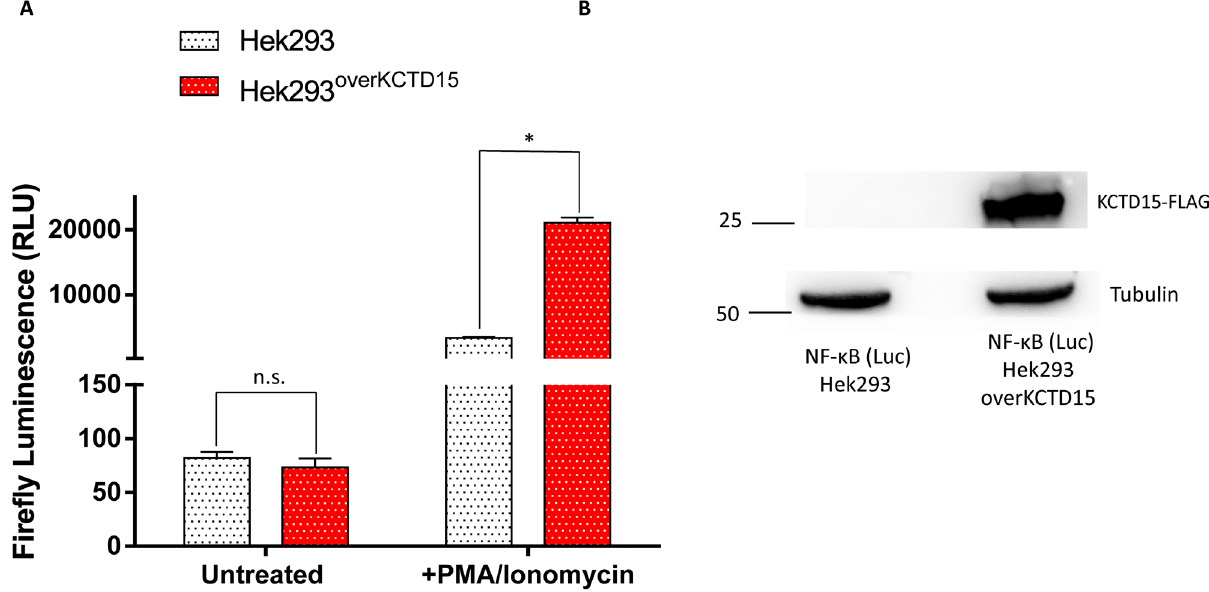
Figure 3. KCTD15 over-expression is associated with the hyper-activation of the NF-κB pathway. ( A ) Bar-plot diagram of firefly luciferase signal in NF-κB reporter (Luc)-HEK293 control (white dotted bars) and in NF-κB reporter (Luc)-HEK293 over-expressing KCTD15 (red dotted bars). Errors represent ± SD of three independent experiments. *p-value < 0.05, Mann–Whitney t test. ( B ) Western blot analysis of NF-κB reporter (Luc)-HEK293 control and NF-κB reporter (Luc)-HEK293 over-expressing KCTD15-FLAG. B-tubulin was used as an internal control. Numbers represent molecular weight protein